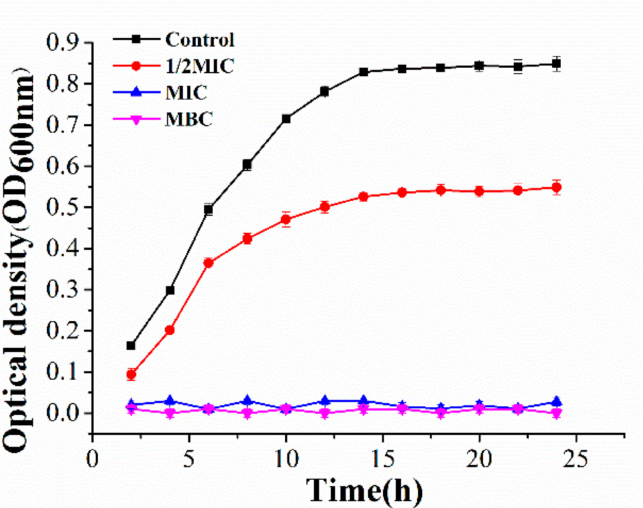
Figure 1. Growth curve of P. syringae exposed to